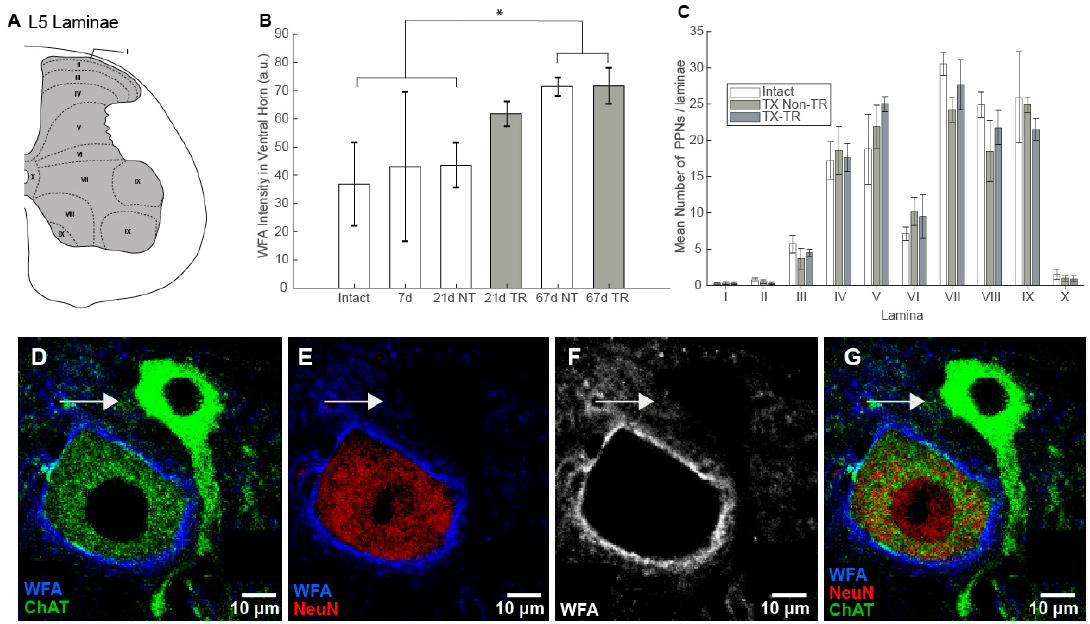
Figure 2. Schematic of laminar distribution at lumbar segment 5 (L5). ( A ) Intensity of WFA staining in the spinal cord grey matter. ( B ) A significant difference was observed between 67dpi groups and intact, 7d, and 21dNT groups. ( C ) Number of PNNs in the intact and 67dpi groups. Laminae I, II, III, and X demonstrated the lowest number of PNNs. However, there were no significant differences between groups for any lamina. Γ -MNs do not express PNNs: ( D–G ) motoneurons in the ventral grey matter labeled with ChAT (green); only α -MNs co-labeled with NeuN (red), whereas γ -MNs (arrow) are NeuN-. ( E , F ) α -MNs are clearly enveloped by a perineuronal net (WFA), but γ -MNs do not express any organized perineuronal net (F, image shown in black and white for clear visualization). * = p < 0.05. TX Non TR = Transected, non-trained; TX TR = Transected